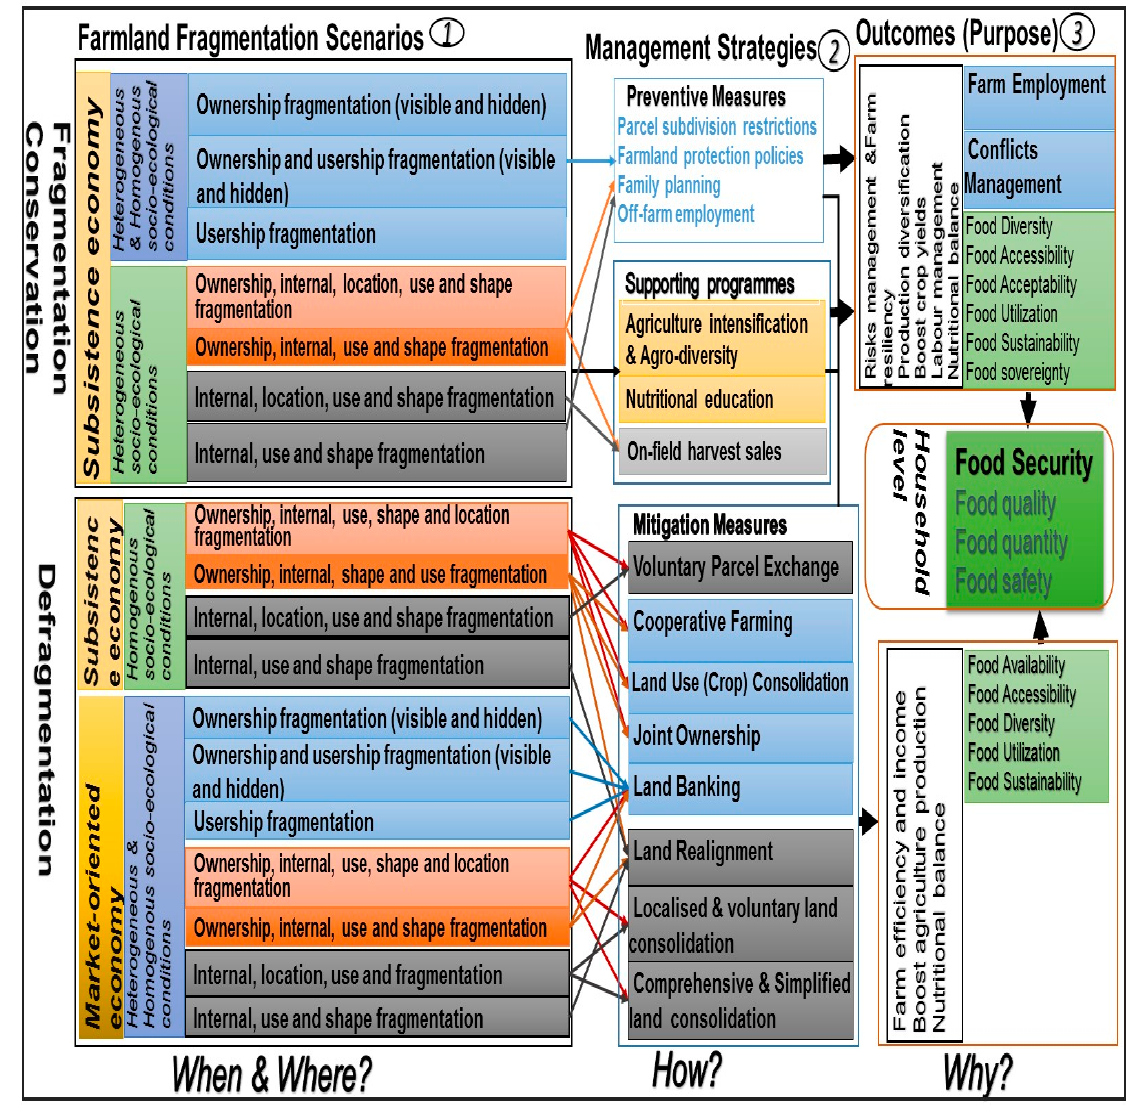
Figure 5. Farmland Fragmentation Management Conceptual Model. Source: Developed from the reviewed literature and the logic conceptual reasoning and modelling [11,73–75,77,81,87].